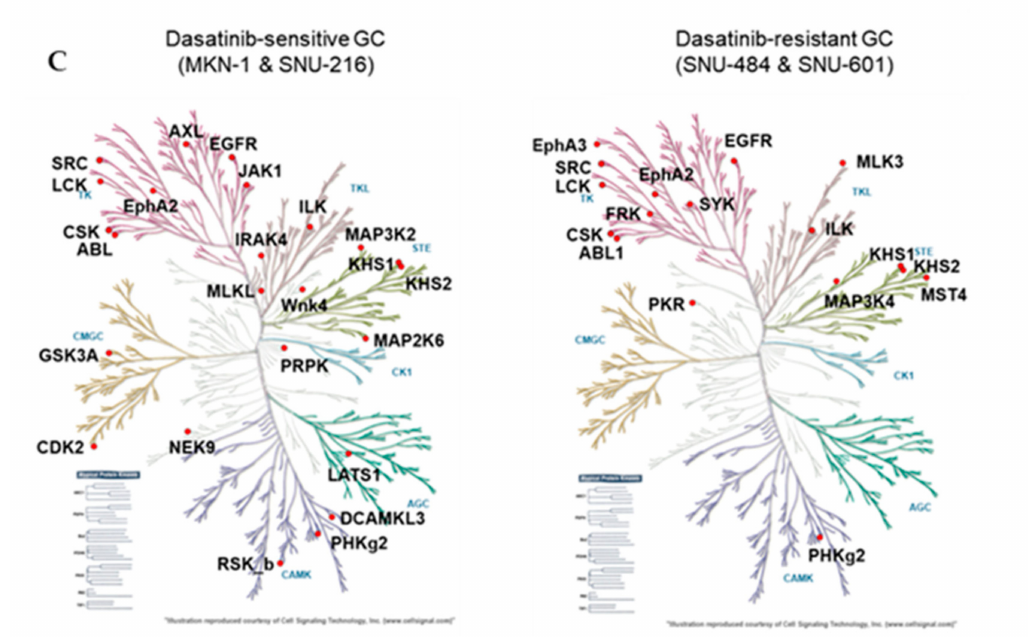
Figure 4. Di ff erential dasatinib target profiling between dasatinib-sensitive and -resistant GC. ( A ) Venn diagram showing dasatinib target kinases in dasatinib-sensitive and -resistant GC. ( B ) Protein–protein interaction networks for dasatinib target kinases identified from dasatinib-sensitive and -resistant GC. The STRING database was used to map protein–protein interactions and Cytoscape software was used to illustrate the resulting network. ( C ) Dasatinib target kinases in sensitive and resistant GC cells illustrated in the kinome